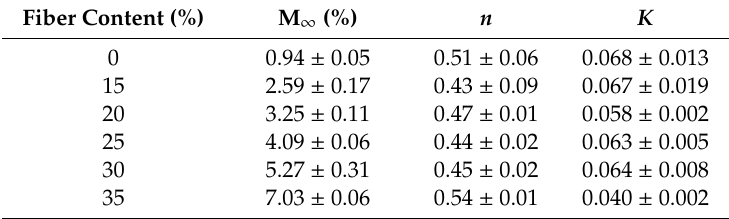
Table 5. Fick’s constants calculated from the experimental results in PLA and its composite materials. Fiber content (%)